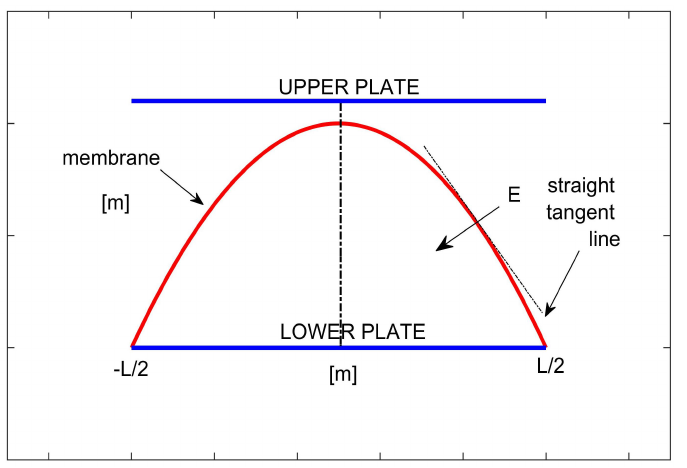
Figure 1. Schematic of the 1 D membrane MEMS device studied. The parallel metallic plates are represented in blue, whereas the membrane is indicated in red. The orthogonality between E and the tangent line to the membrane are also